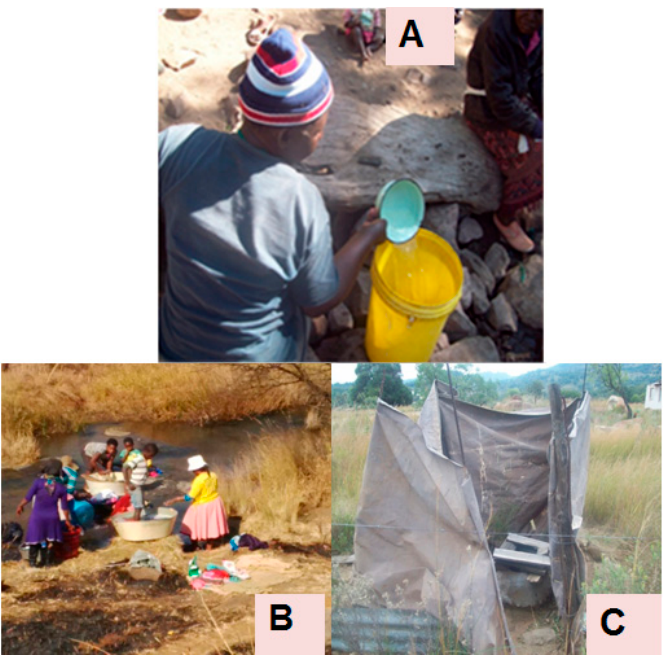
Figure 3. Community member of Makwane collecting water from one of the unprotected sources ( A ); community members doing their laundry in one of the rivers ( B ) where they also collect water for domestic purposes; and ( C ) one of the unsafe pit latrines of Makwane Village.